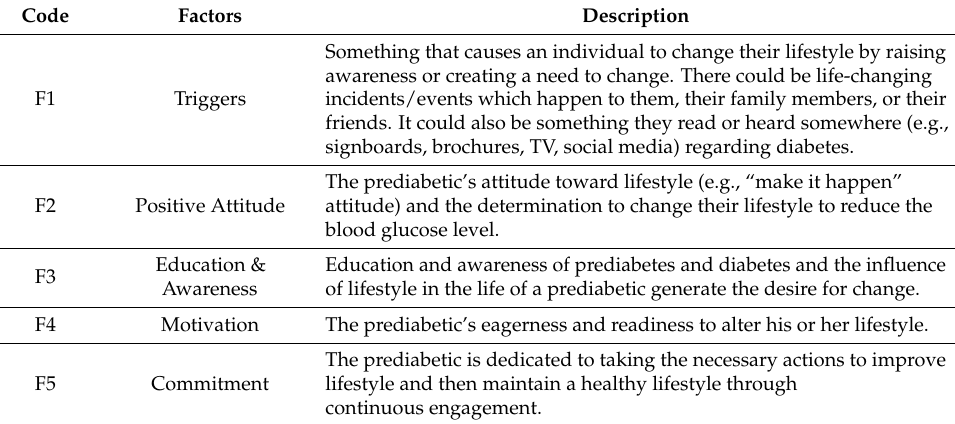
Table 2. The contributing factors.